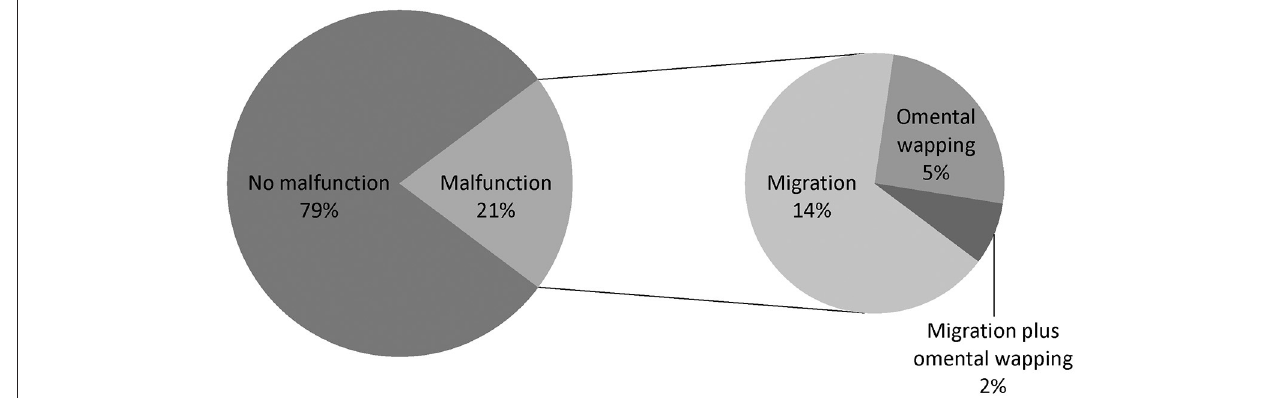
FIGURE 4 | Catheter dysfunction types in urgent-start peritoneal dialysis.